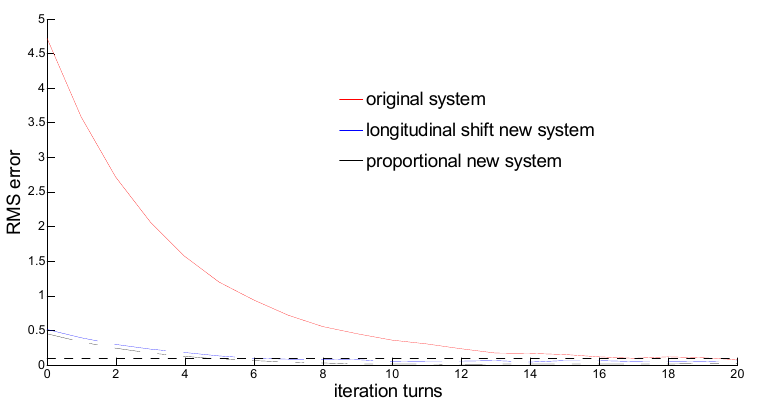
Figure 8. ILC of Experience Amplitude Adjusting Transform.